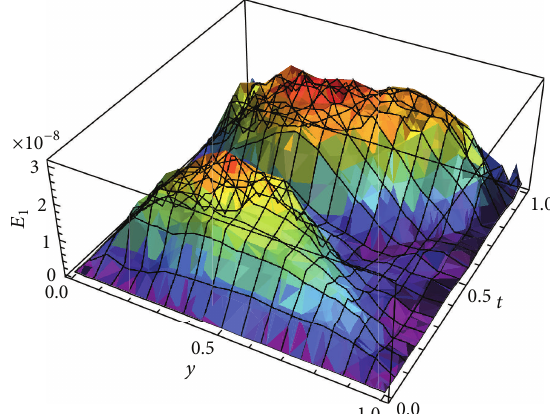
Figure 9: The approximate ̃𝑢 and the exact 𝑢 solutions for different values of 𝑡 = 0.1 , 0.5, and 0.9 of problem (51), where 𝑁 = 12 and 𝛼 = 𝛽 = −(1/2) in the interval [0, 1]